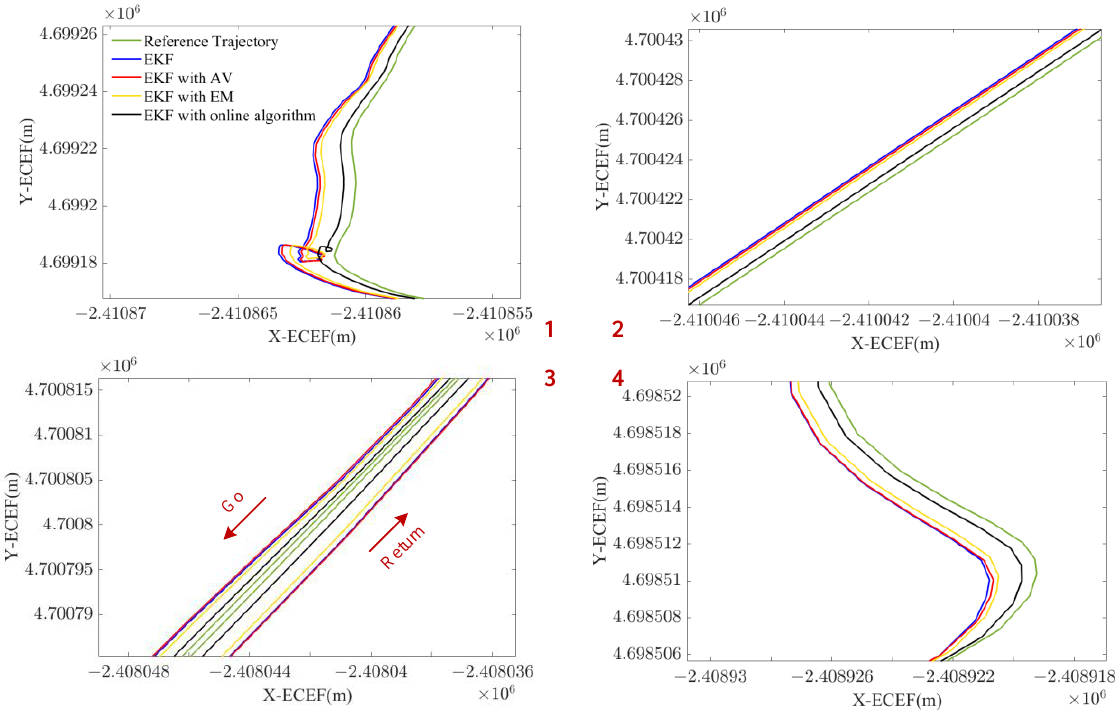
Figure 10. Four detailed figures of trajectories generated by the four